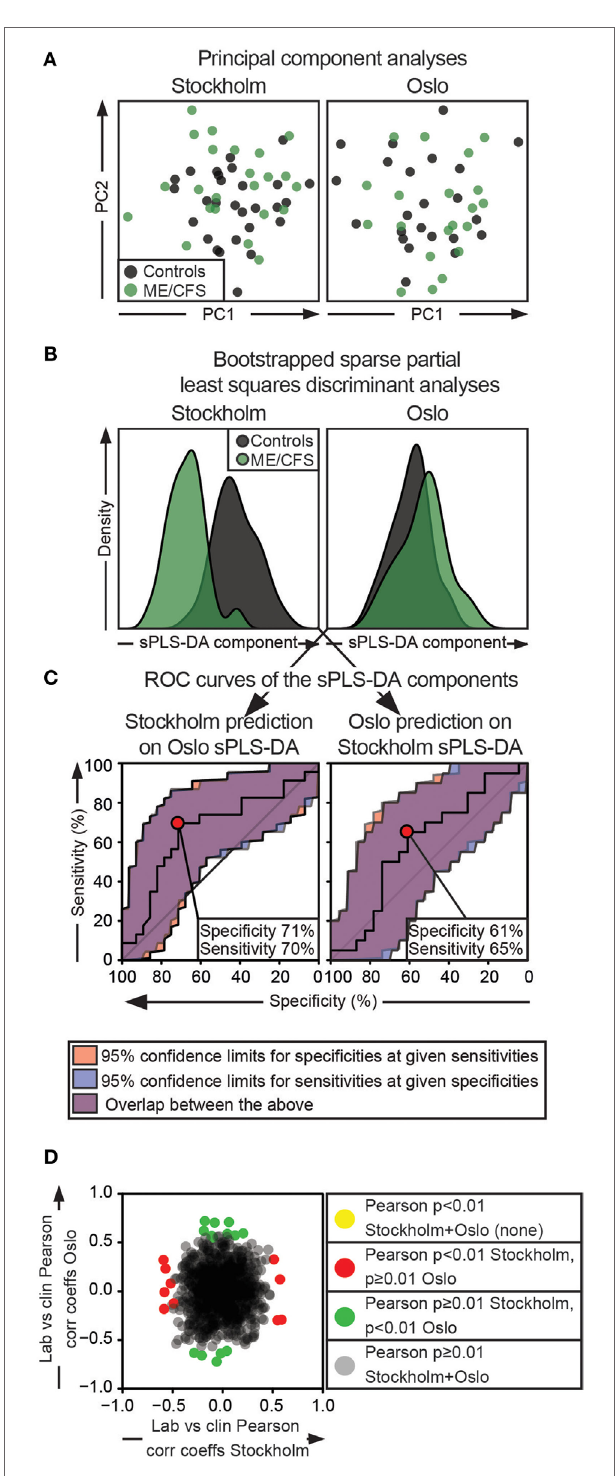
can separate both Oslo and Stockholm patients from controls. Separate analyses for the Stockholm and Oslo substudies are represented in the first and second column, respectively. (a) Principal component (PC) analysis. X - and Y -axes show the estimated PC1 and PC2, respectively. Black and green dots indicate control and ME/CFS individuals, respectively. (b) Histograms show the sparse partial least squares discriminant components for the separate analyses. Gray and green colors indicate controls and ME/CFS patients, respectively. (c) Receiver-operating characteristic (ROC) curves are shown. The left ROC curve is based on a crossover discriminant component of Stockholm dataset generated by multiplying the variable and the loading identified in the Oslo sPLS-DA. The right ROC curve is generated in the corresponding way for the Oslo dataset. (D) Oslo Pearson product-moment correlation coefficients are plotted as a function of Stockholm Pearson product-moment correlation coefficients for correlations of clinical vs cytotoxic lymphocyte parameters. Gray dots show correlations that are insignificant in both substudies. Red and green dots show significant correlations in the Stockholm and Oslo substudies, respectively. Yellow dots should show correlations that overlap between the analyses (none present). For the Stockholm and Oslo substudies, respectively, 23 + 28 and 20 + 23 patients + controls are included in the